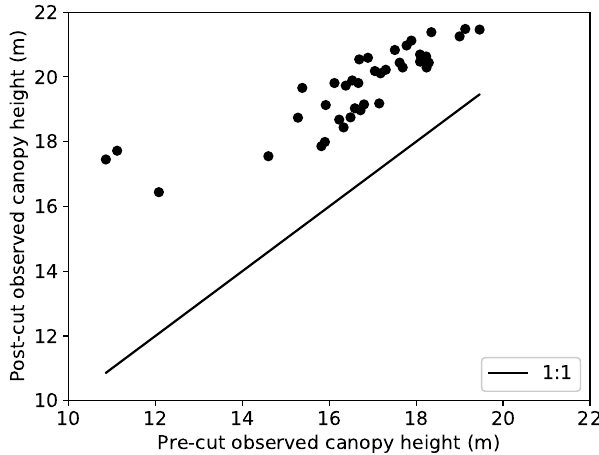
Figure 12. Differences in Canopy Height Models (CHM) for CHM post-cut − CHM pre-cut ≥ 2 m in the removal